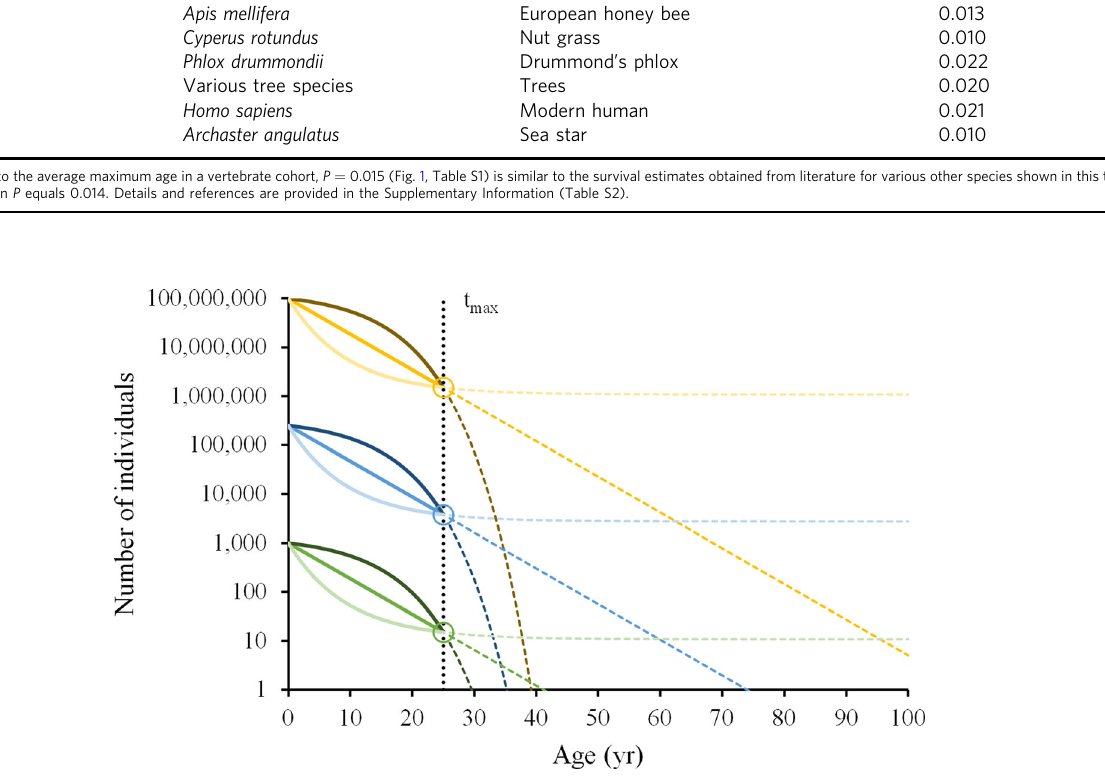
Fig. 2 The number of survivors to a certain age under different survivorship patterns and initial cohort (or sample) sizes. Individual survivors to the average maximum age in a cohort, t max , of 25 years (black dotted vertical line), representing 1.5% of the initial numbers ( P = 0.015, open circles). Shown are scenarios for constant mortality, mortality increasing with age (dark colours) and mortality decreasing with age (light colours). The coloured dotted lines show the expected trajectory of these scenarios from 1.5% survivorship until the theoretical maximum age reached by 1